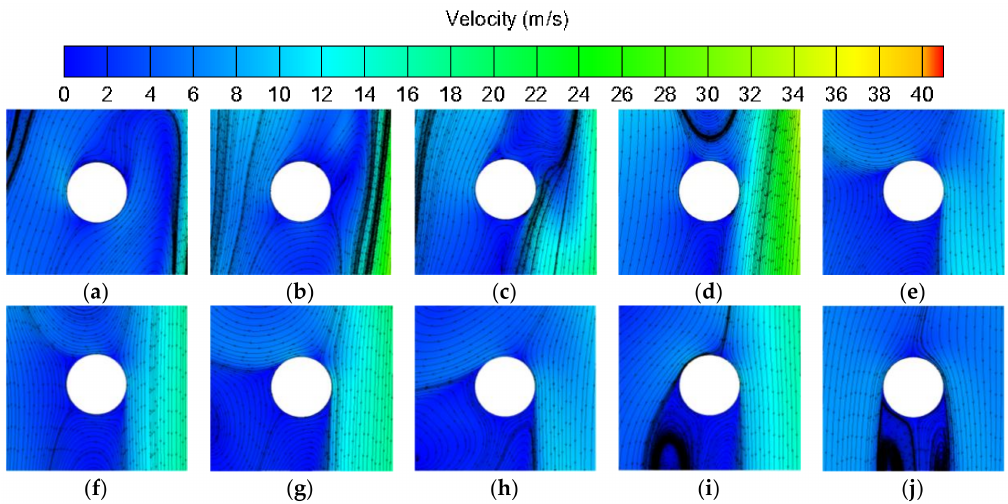
Figure 9. Local flow structure around the circular cylinder at R = 0.117 without vanes: ( a ) z / D h = 0.5; ( b ) z / D h = 1; ( c ) z / D h = 1.5; ( d ) z / D h = 2; ( e ) z / D h = 3; ( f ) z / D h = 4; ( g ) z / D h = 5; ( h ) z / D h = 6; ( i ) z / D h = 7; ( j ) z / D h = 9.